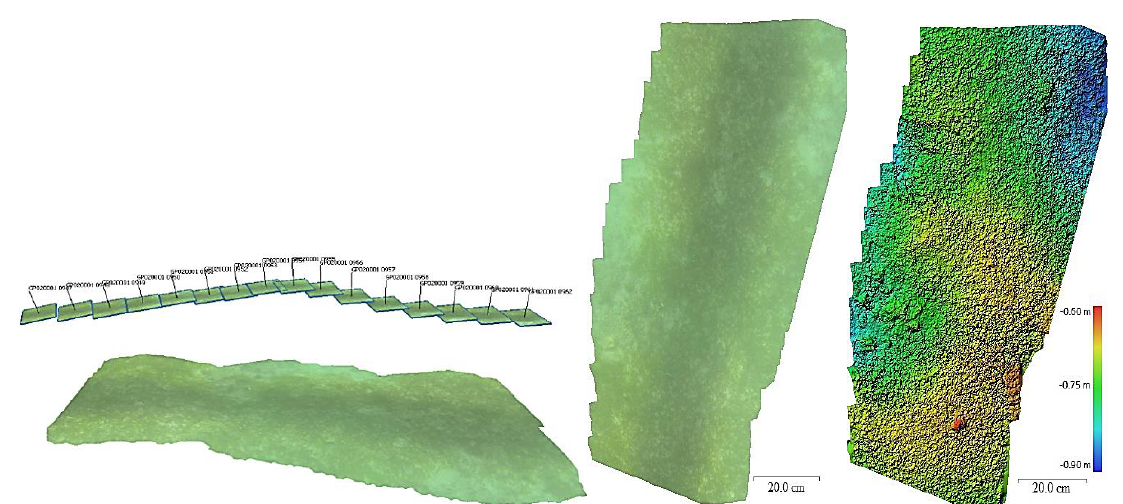
Figure 11. 3D perspective view, orthophoto mosaic, and DTM for a categorized seagrass sample.